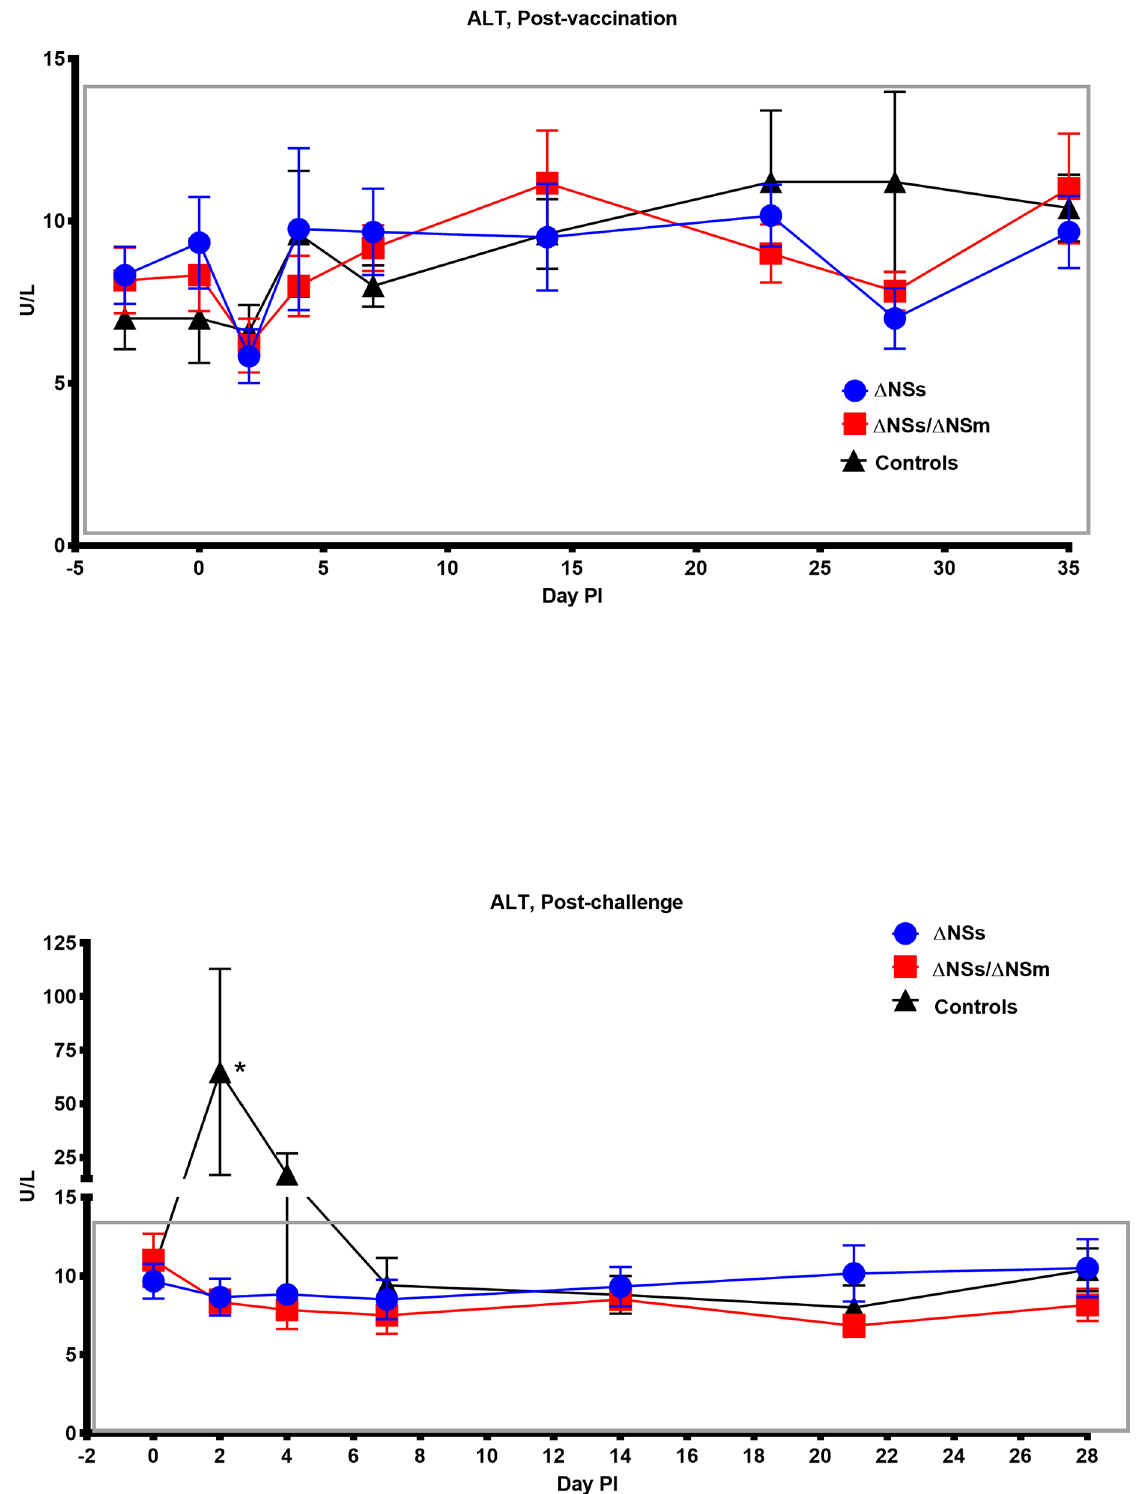
Fig 4. Alanine aminotransferase (ALT) levels of marmosets post-vaccination (top) and post-challenge (bottom). ALT levels in the blood of marmosets post-vaccination (top) with rZH501- Δ NSs (n = 6), rZH501- Δ NSs- Δ NSm(n = 6), or sham inoculated controls (n = 5) and post-challenge (bottom) with 6 log 10 PFU of the virulent strain ZH501. The boxes represent the normal ALT reference range variability